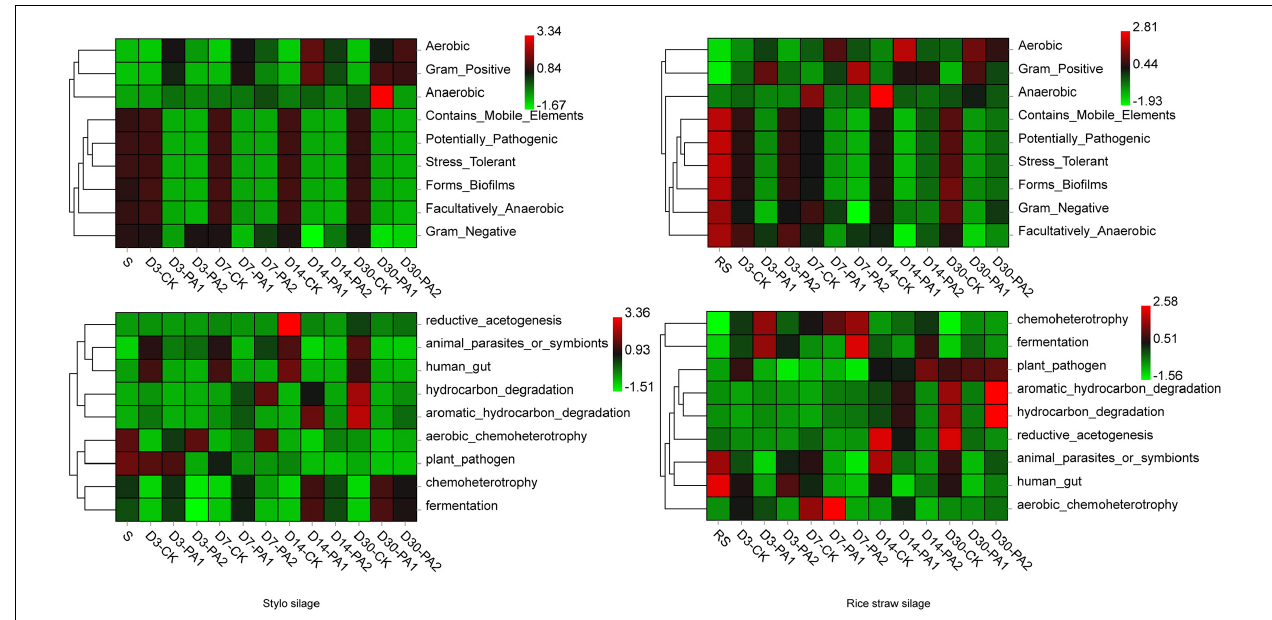
FIGURE 5 | Heatmap of phenotypic characteristics and predicted functional profiles of detected bacterial communities in stylo and rice straw before and after ensiling for 3, 7, 14, and 30 days with or without 1% or 2% pyroligneous